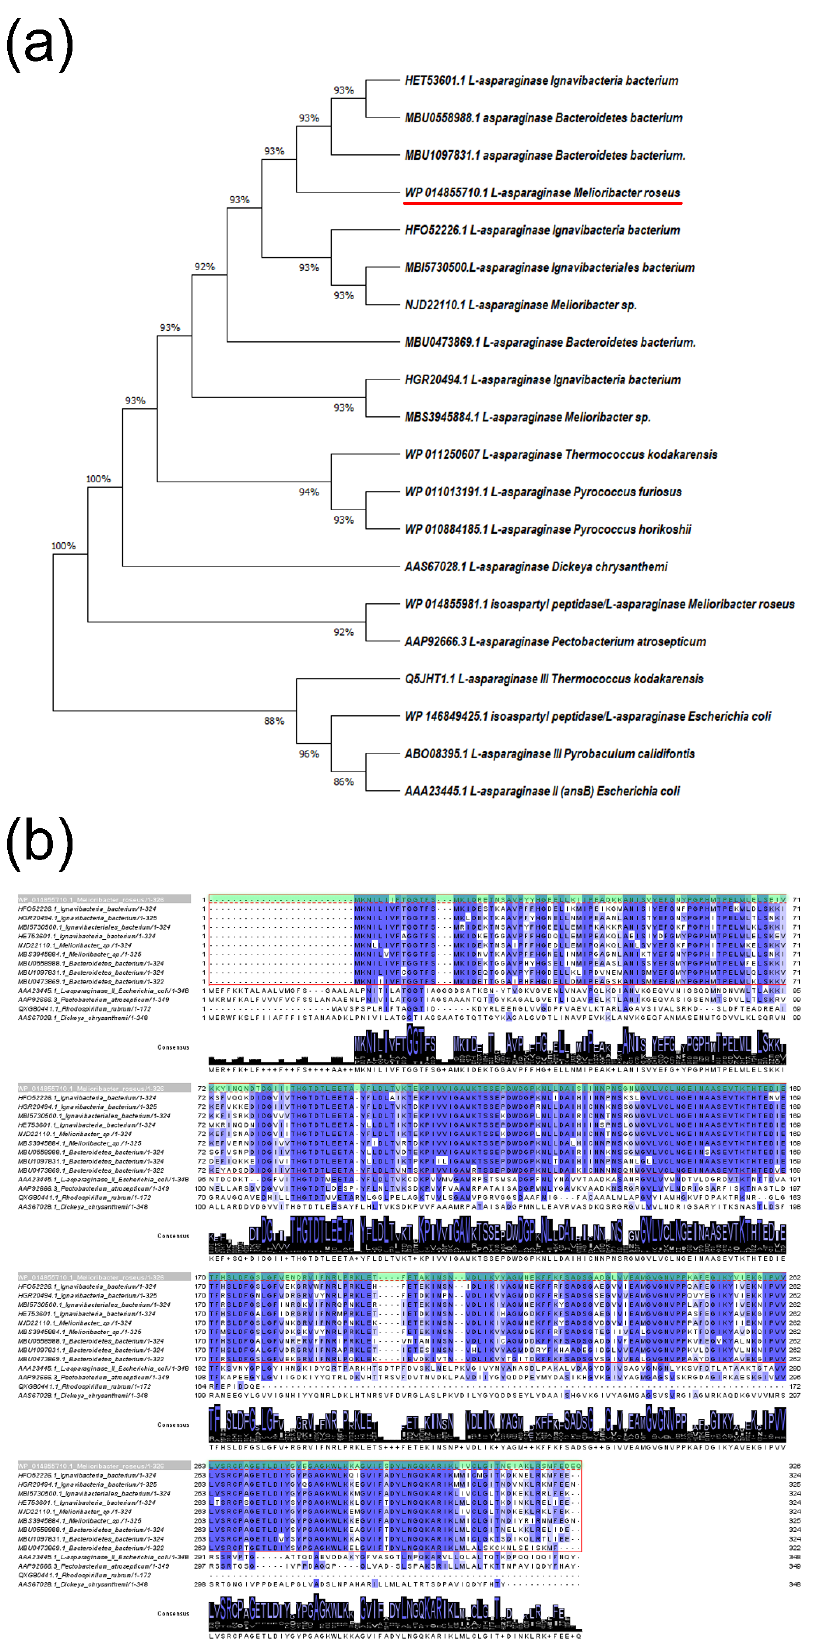
Figure 1. Comparison of L-asparaginases (L-ASNases) from M. roseus . ( a ) Molecular phylogenetic analysis of selected L-ASNases using the minimum evolution method [37]. The analysis